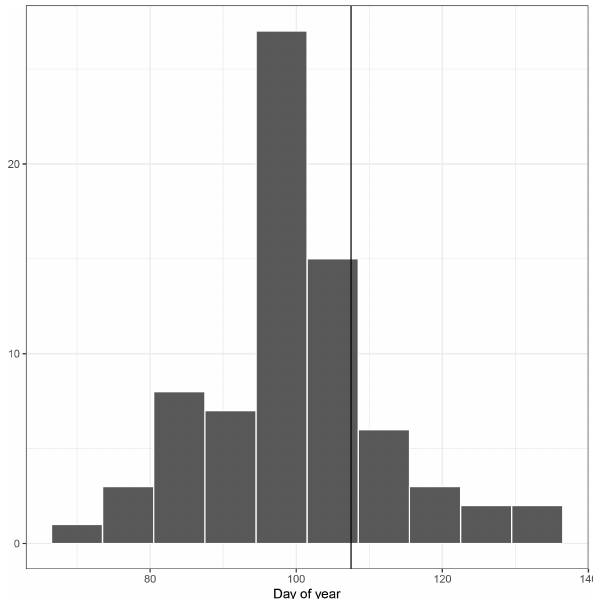
Figure 6. Histogram of last spring freeze days. This figure shows the distribution of last spring freeze days in Richmond, Virginia, from 1942 to 2017. The black vertical line shows the median last spring freeze events in the data extracted from the Shirley Planta- tion document covering the period 1822–1838. There was one year where no freeze events were documented for the spring. This leaves 16 years in the historical